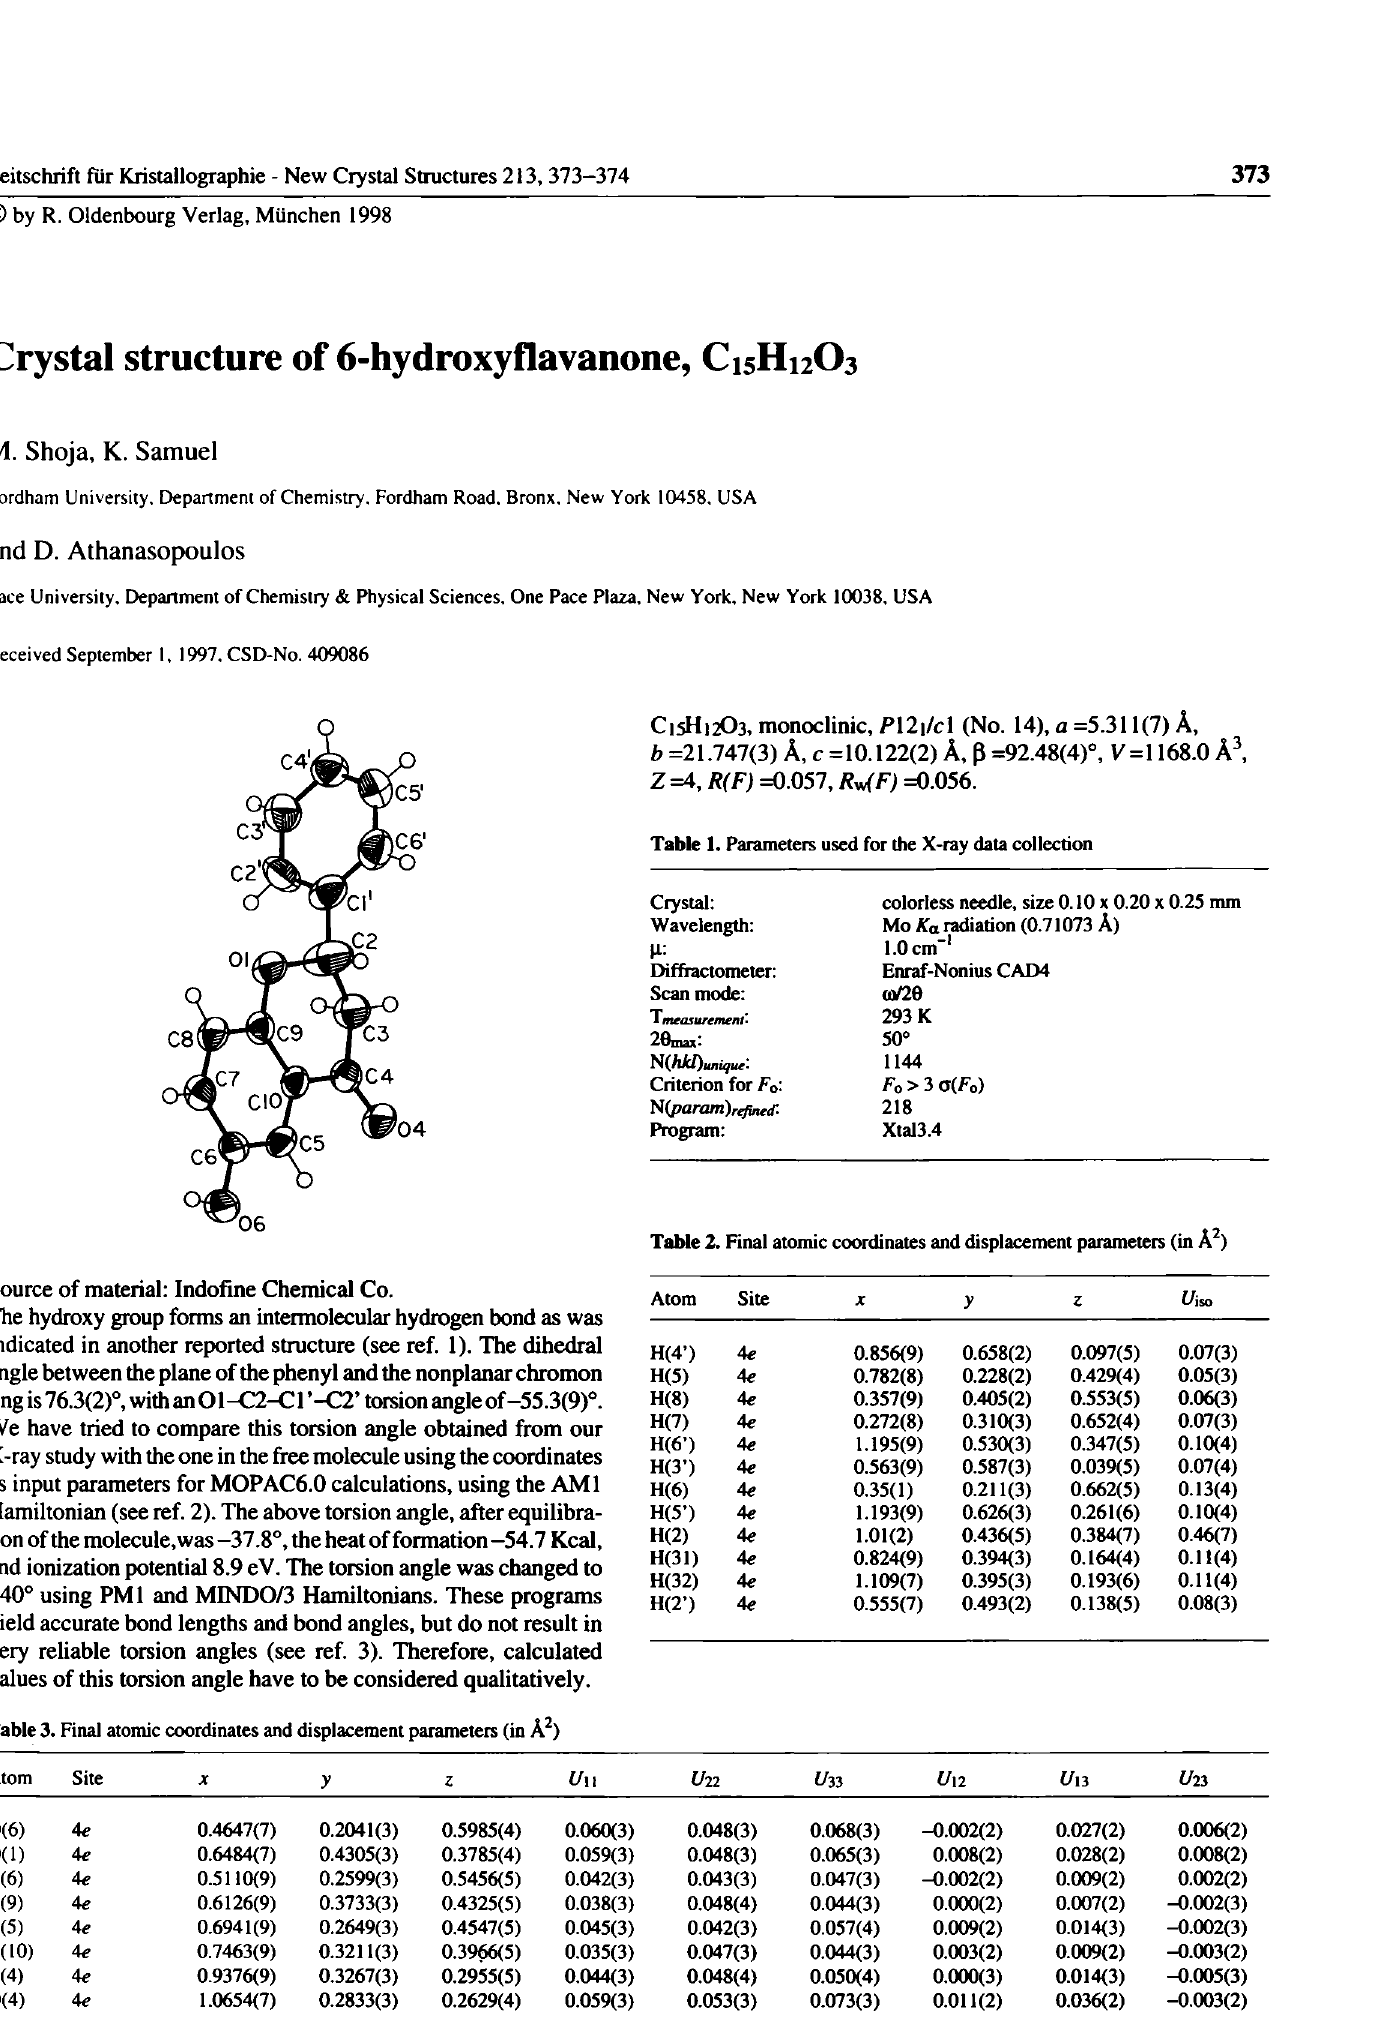
Table Э. Final atomic coordinates and displacement parameters (in Â})